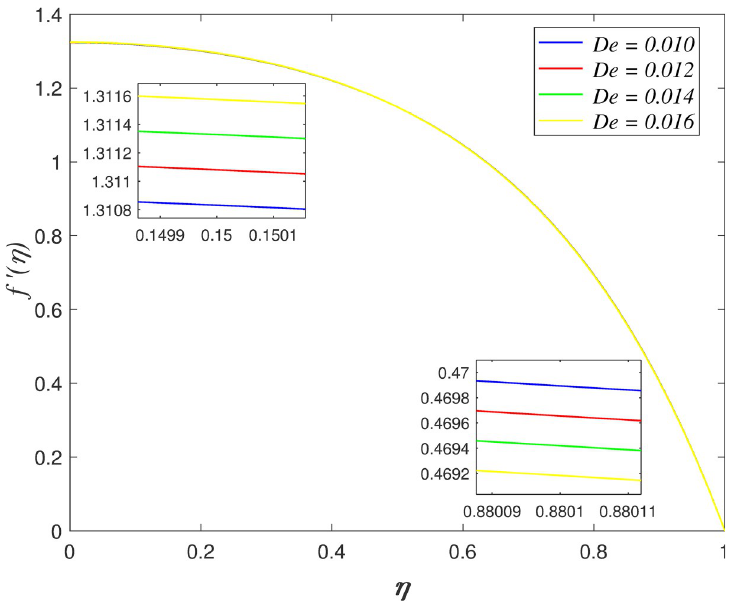
Fig 15. Impact of De on axial